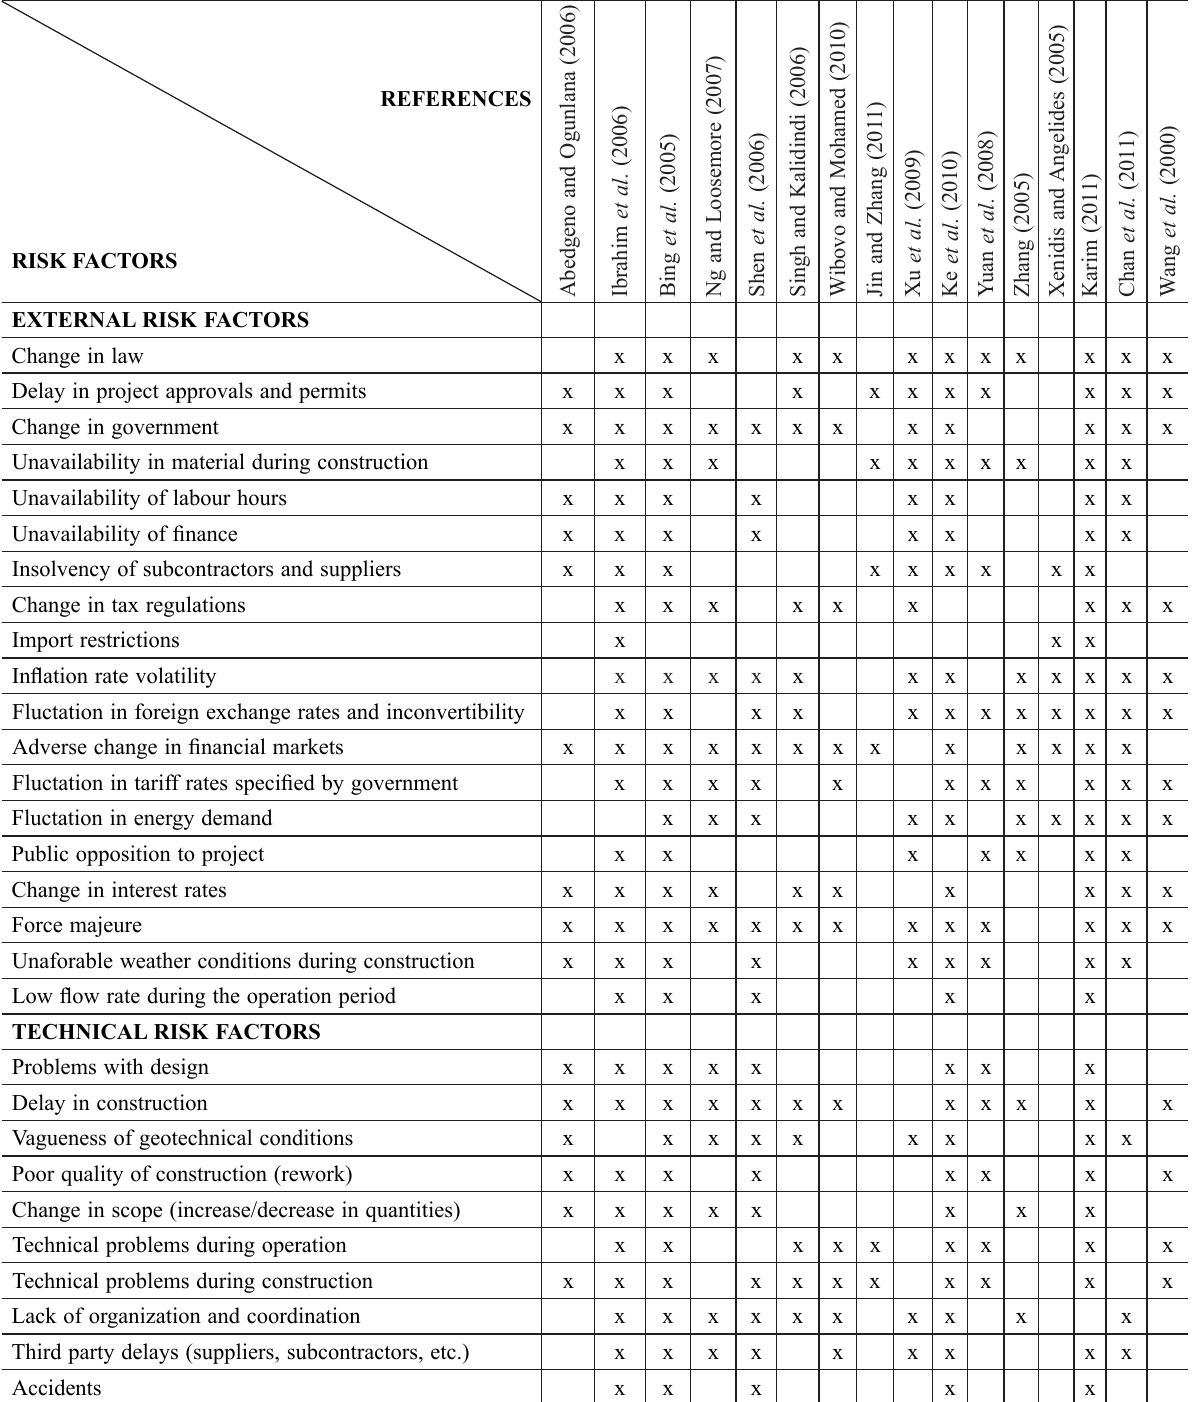
Table 1. External and technical risk factors for hydropower